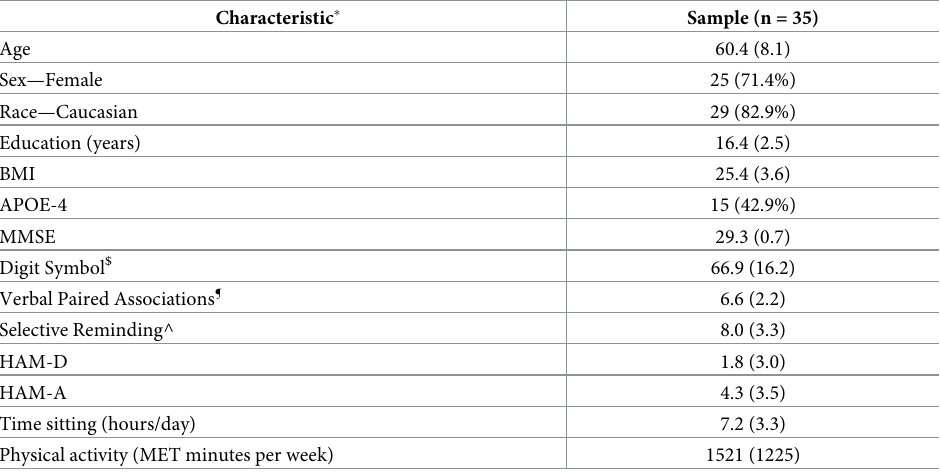
Table 1. Demographic, clinical and physical activity characteristics of study